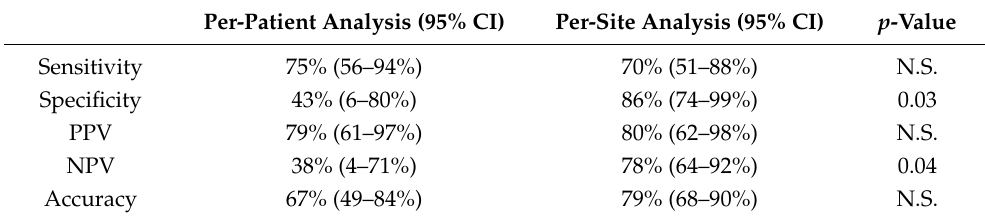
Table 2. The results and comparison of per-patient and per-site analyses of the diagnostic performance of choline-PET/CT in predicting pelvic lymph node involvement.